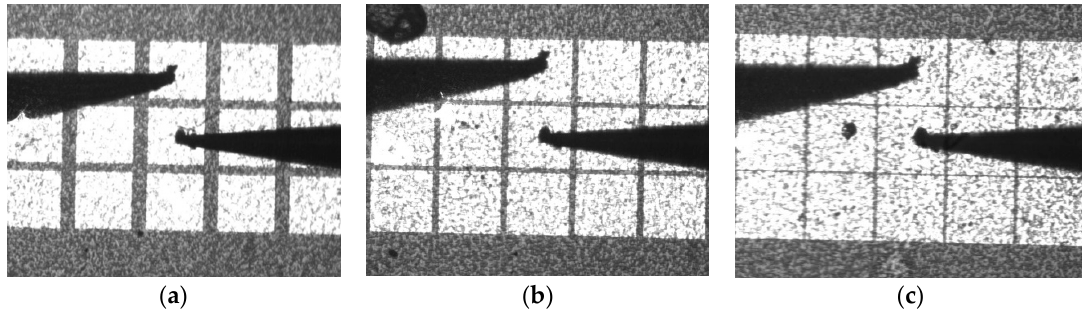
Figure 2. Pictures of ( a ) 30 µm; ( b ) 15 µm; and ( c ) 5 µm channel gap Si nanonet